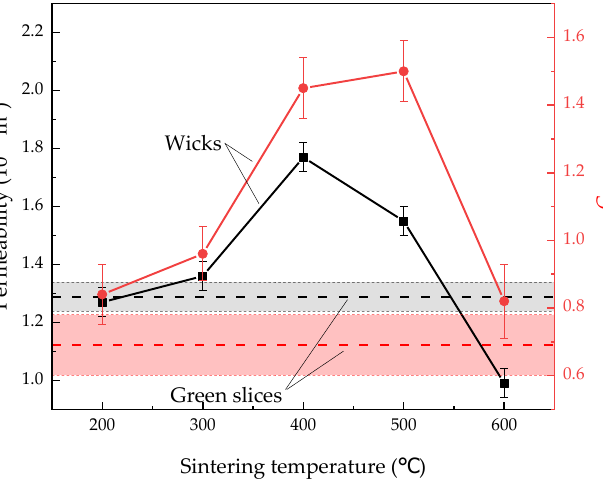
Figure 9. Permeability and C of green slices and wicks sintered at different temperatures.